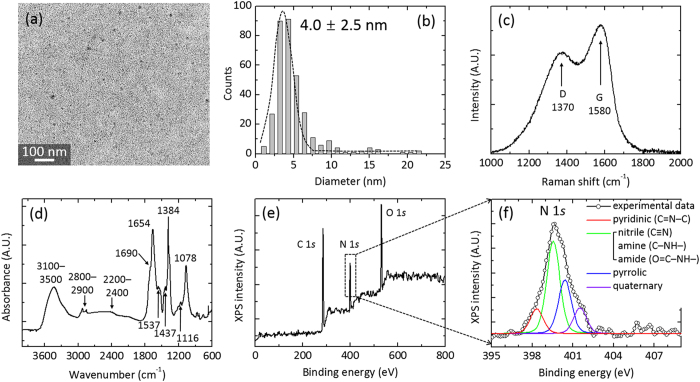
Electron microscopic and spectroscopic analyses of N-CDs.(a) TEM image and (b) diameter histogram of the N-CDs. (c) Raman, (d) FT-IR, (e) XPS, and (f) peak-fitted N 1 s XPS spectra of N-CD layer. The peak fitting was performed by peak de-convolution using symmetric Voigt functions.